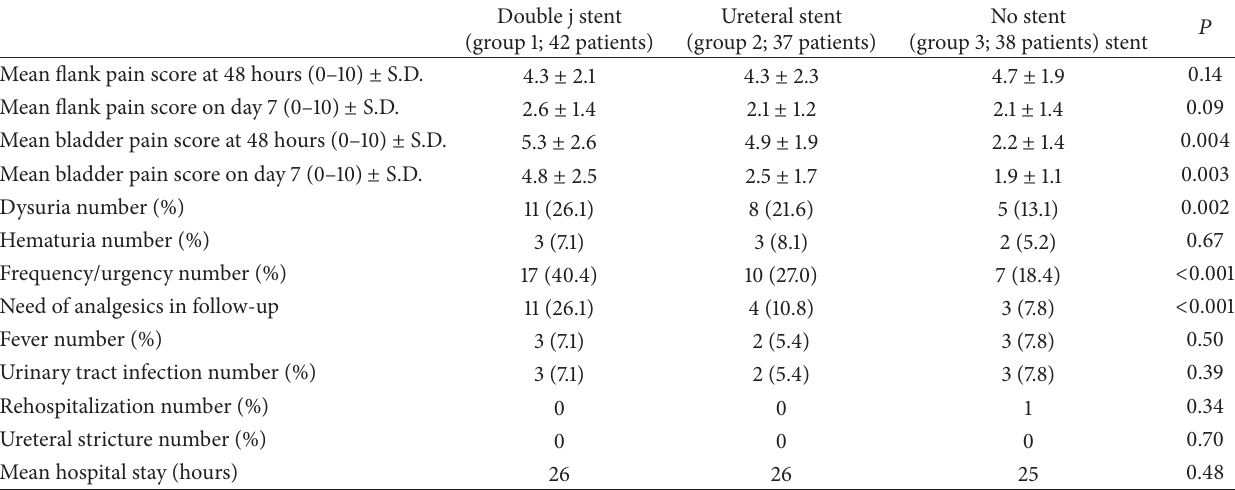
Table 2: Postoperative symptoms and